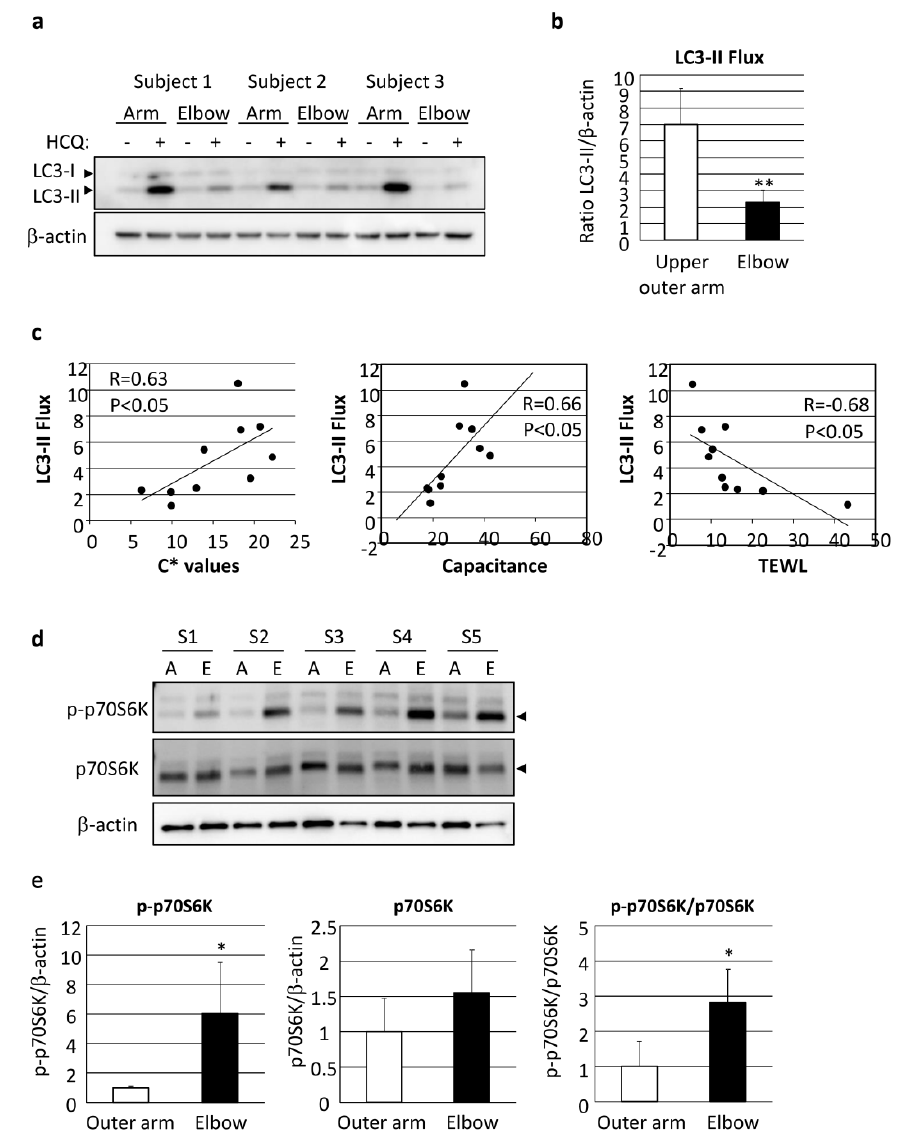
Figure 6. Depression of autophagic flux through stimulation of mTORC1 activity has significant impact on skin color and skin hydration. ( a ) Skin tissues obtained from upper outer arm (arm) and elbow regions of AA subjects were cultured with or without 10 µ M HCQ for 48 h, followed by western-blotting analysis using an LC3-specific antibody. β -actin = loading control. ( b ) Following normalization with β -actin, the amount of LC3-II was compared between the presence and absence of HCQ. Values are shown as the mean ± SD from five independent AA subjects. ** p < 0.01 (paired t-test). ( c ) Correlations shown between LC3-II flux and C* (left), skin capacitance (center) and TEWL (right). Samples were obtained from the upper outer arm and elbow skin regions of five AA subjects. ( d ) Proteins were harvested from punch-biopsy-obtained skin tissues from the upper outer arm (A) and elbow (E) regions, and subjected to western blotting for phosphorylated-p70S6 kinase (p-p70S6K) or total p70S6K. β -actin = loading control. ( e ) Graphs show relative intensity of p-p70S6K (left), p70S6K (center) and p-p70S6K / p70S6K (right) after normalization. Values are shown as the mean ± SD ( n = 5) and expressed as a ratio as compared with the upper outer arm region. * p < 0.05 (paired t-test).